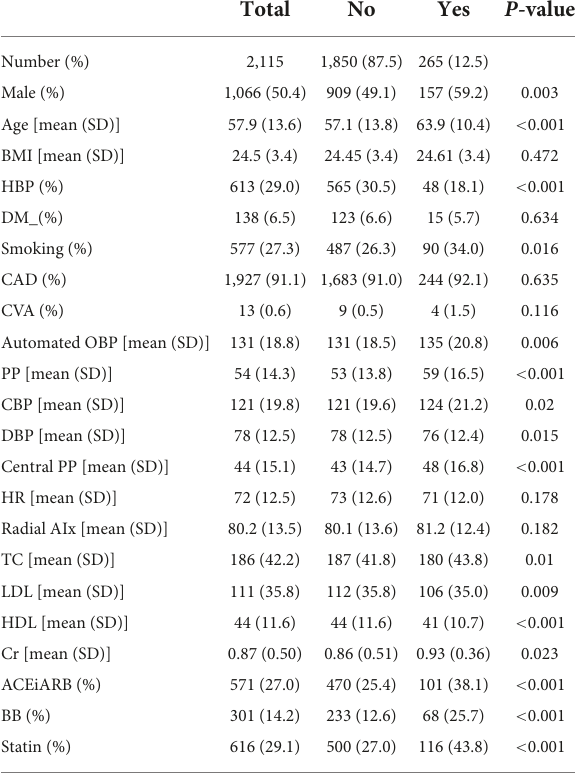
TABLE 1 Baseline characteristics and comparison of demographic variables and cardiovascular risk factors according to incident primary endpoints during follow up